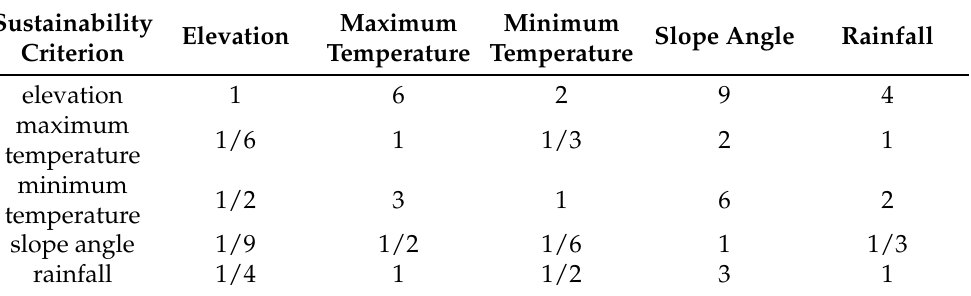
Table 3. A pairwise comparison matrix for the calculation of criteria weights for the citrus site selection by another expert